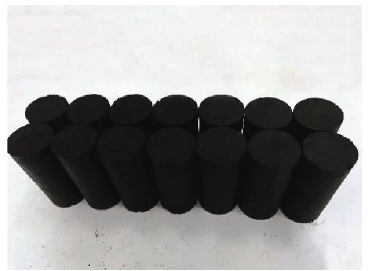
Figure 2: Some coal samples after